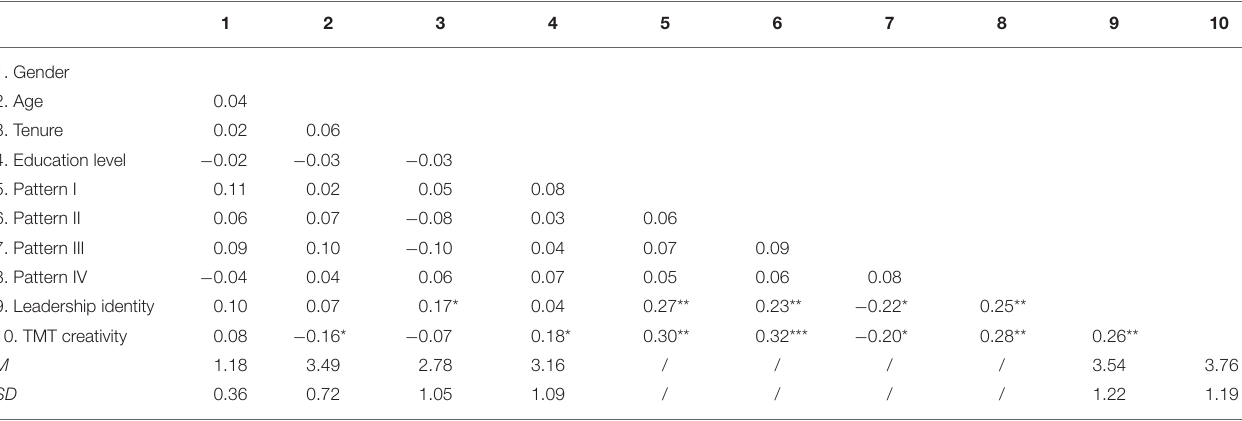
TABLE 2 | The descriptive statistics and correlation coefficients for the